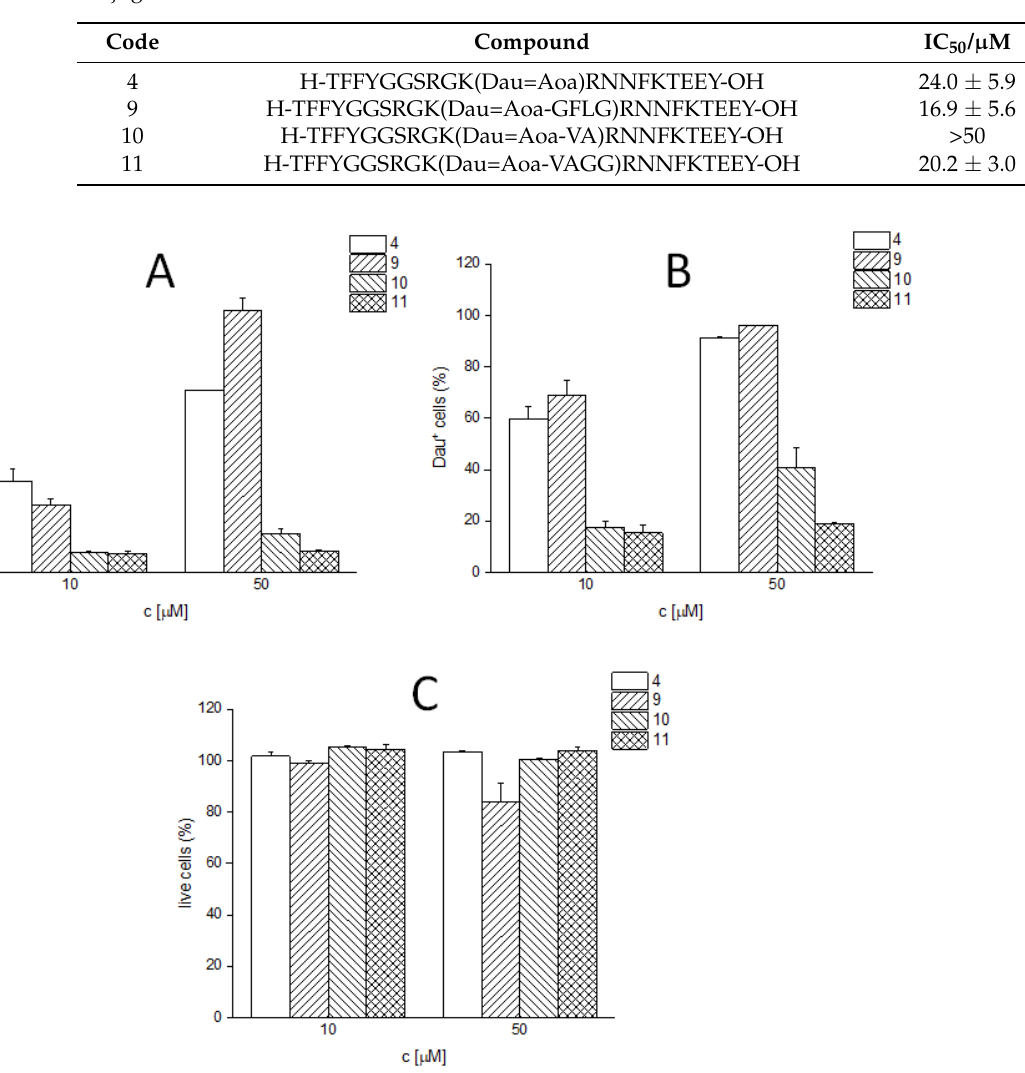
Table 2. The measured IC 50 values of the enzyme-labile spacer containing Angiopep-2–daunomycin conjugates.